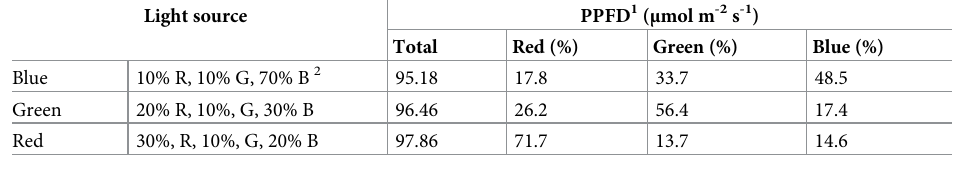
Table 1. The quality of spectra 40 cm beneath the light-emitting diode (LED) panel for three types of LED lights.